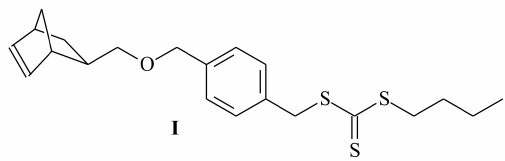
Figure 1. The structure of 4-({[2- exo ]-bicyclo[2.2.1]hept-5-en-2-ylmethoxy} methyl)benzyl butyl car- bonotrithioate ( I